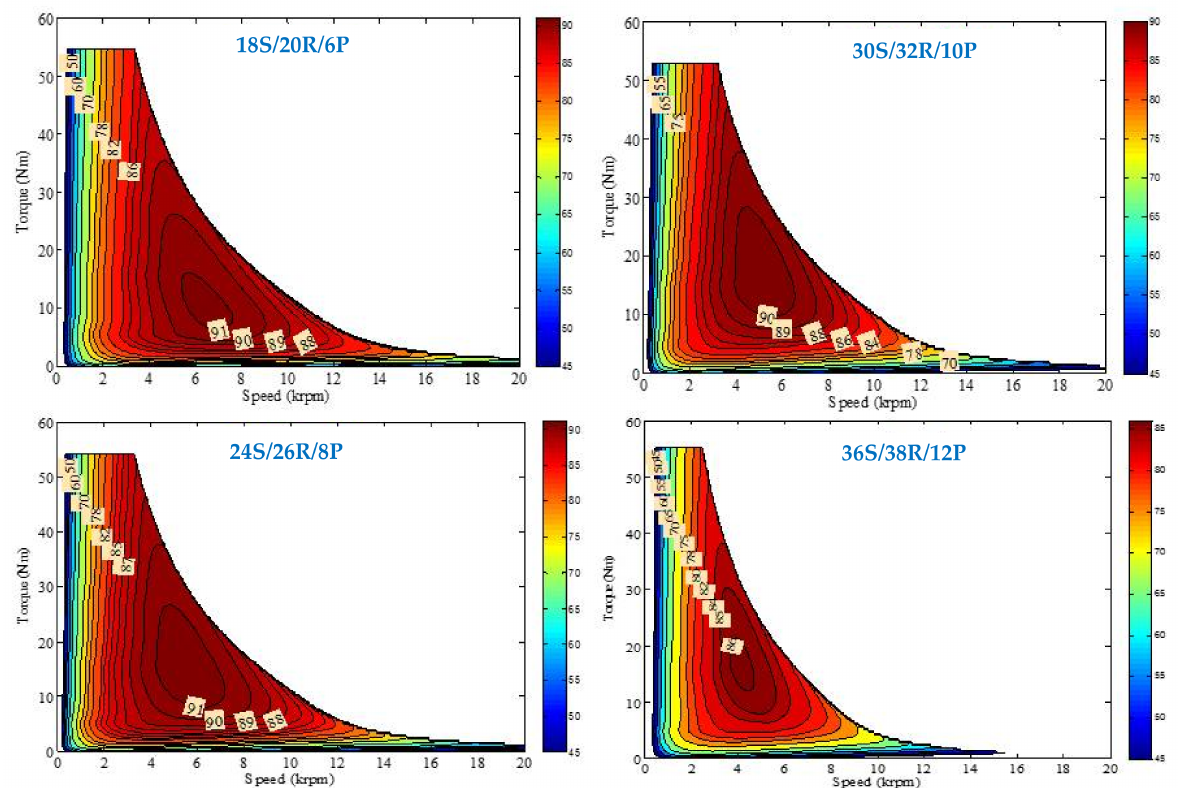
Figure 21. Efficiency map comparison for 80 mm AIMs designed with different stator slot/rotor slot/pole number combinations. The essential factors are described as follows in the accurate selection of the S/P combination of the squirrel cage